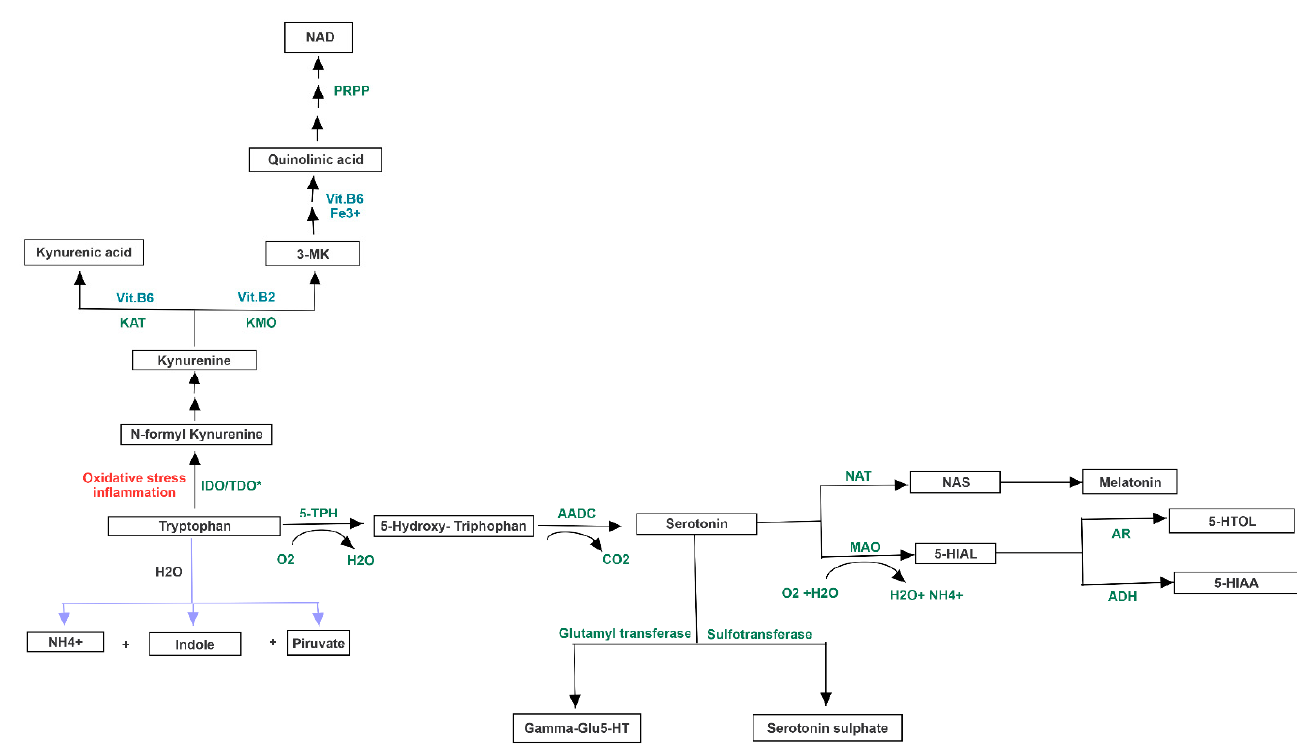
Figure 2. Metabolism of glutamate and GABA linked to ACh. The complex pathway, showing also the involvement of lactate, could play a relevant role in regulation of betaine, a precursor of TMA.